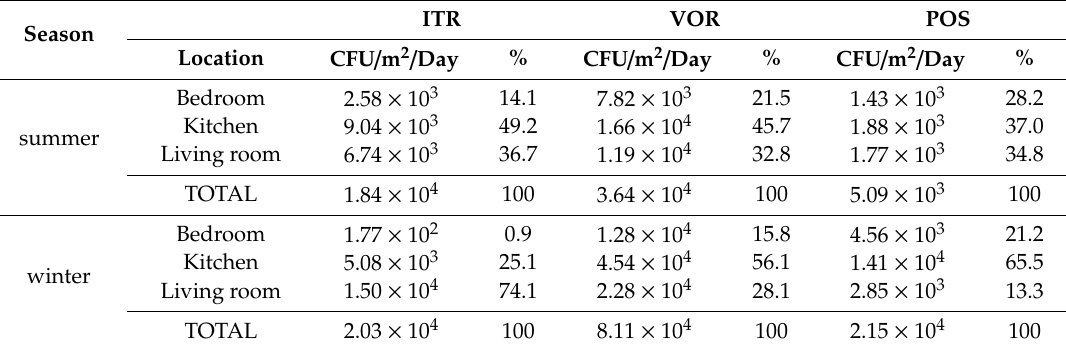
Table 7. Fungal burden found in each home location, per season.